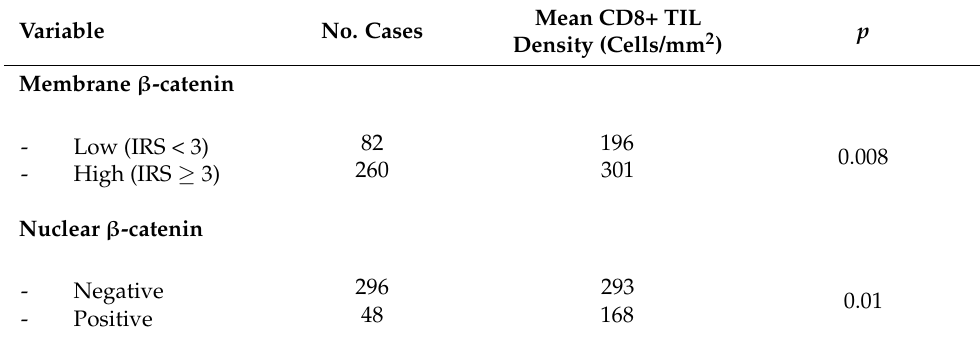
Table 1. Correlations between CD8+ TIL density and β -catenin expression in HNSCC patients.